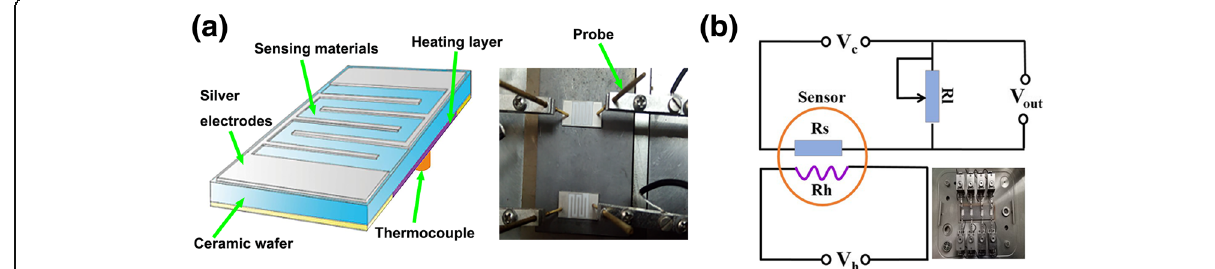
Fig. 2 a Schematic diagram of the gas sensor configuration. b Electric circuit diagram of sensor